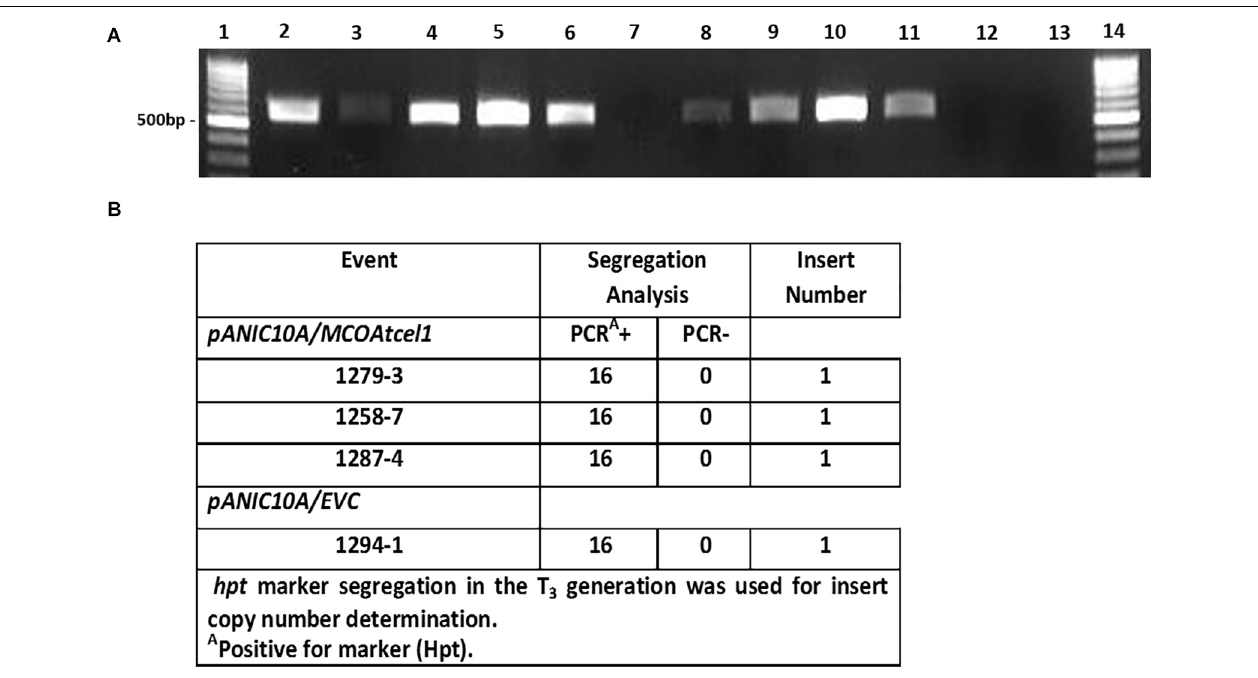
FIGURE 2 | Molecular characterization of transgenic MCOAtcel1 events (A) . Confirmation of MCOAtcel1 transgene expression in 10 independent transgenic S. viridis MCOAtcel1 T 0 events (lane 2–11). The empty vector control T 0 events tested negative for MCO Atcel1 transcript (lane. 12–13). Lane 1 and 14 1 kb marker DNA. (B) PCR-confirmation of single insert status of transgenic T 3 families using hygromycin phosphotransferase ( hpt ) marker gene